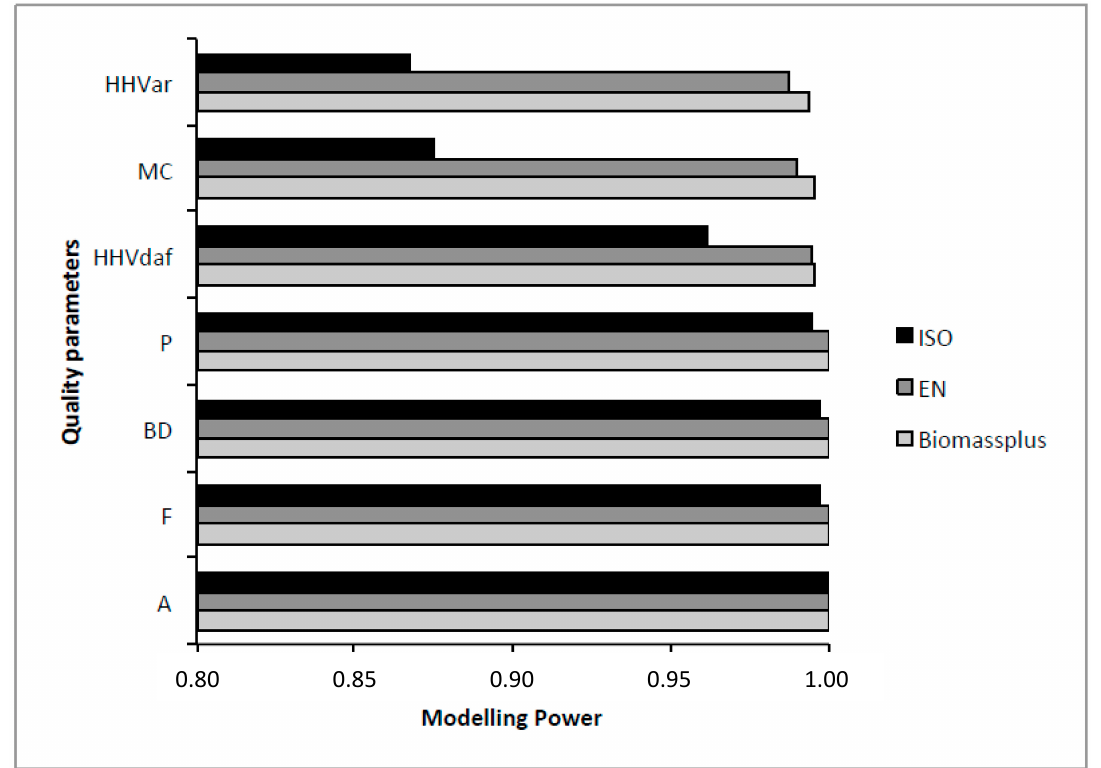
Figure 3. Variables included in the EN, ISO and Biomassplus models ordered by their corresponding modelling power (A: Ashes, F: Fines, BD: Bulk Density, P: Particle size distribution, HHVdaf: High Heating Value dry basis and ash free, MC: Moisture Content, HHVar: High Heating Value as received).